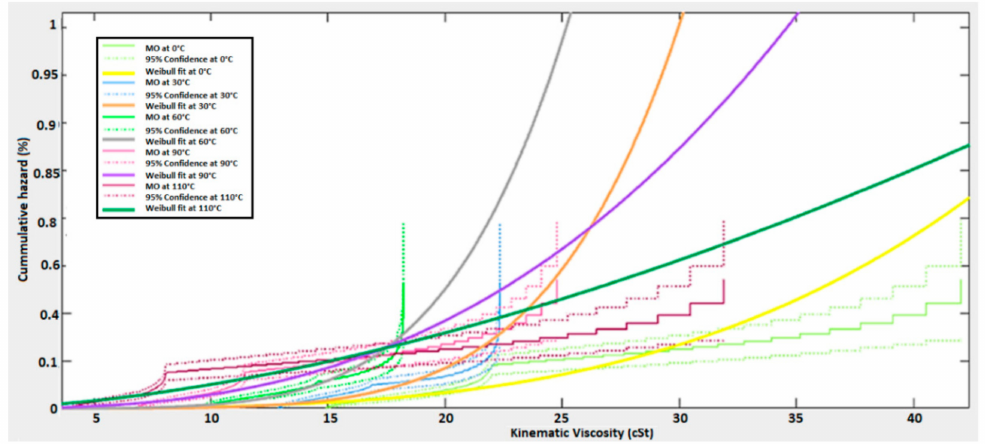
Figure 22. Cumulative hazard of MO showing the data points of kinematic viscosity under varying concentration of Al 2 O 3 in different temperature